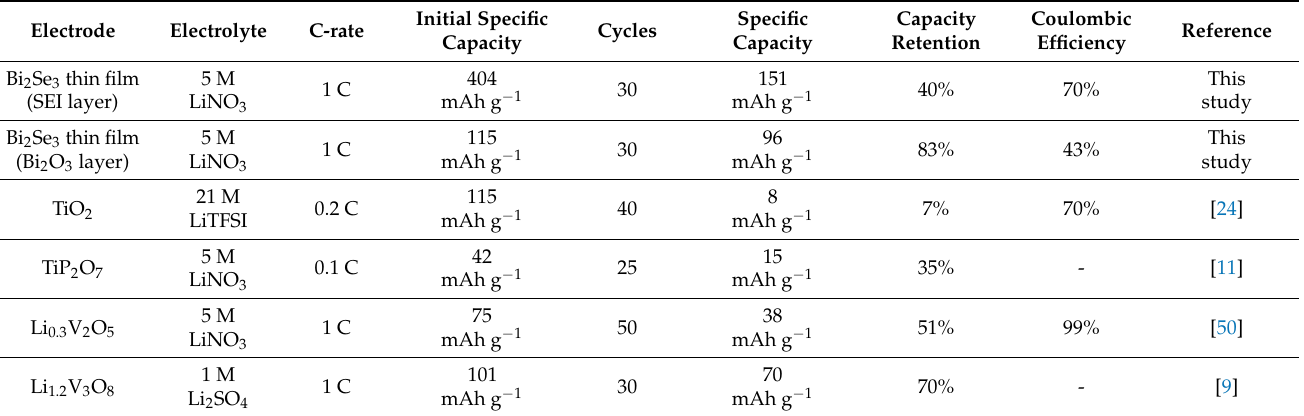
Table 4. Comparison of galvanostatic discharge cycling performances of different anodes in lithium aqueous electrolyte.